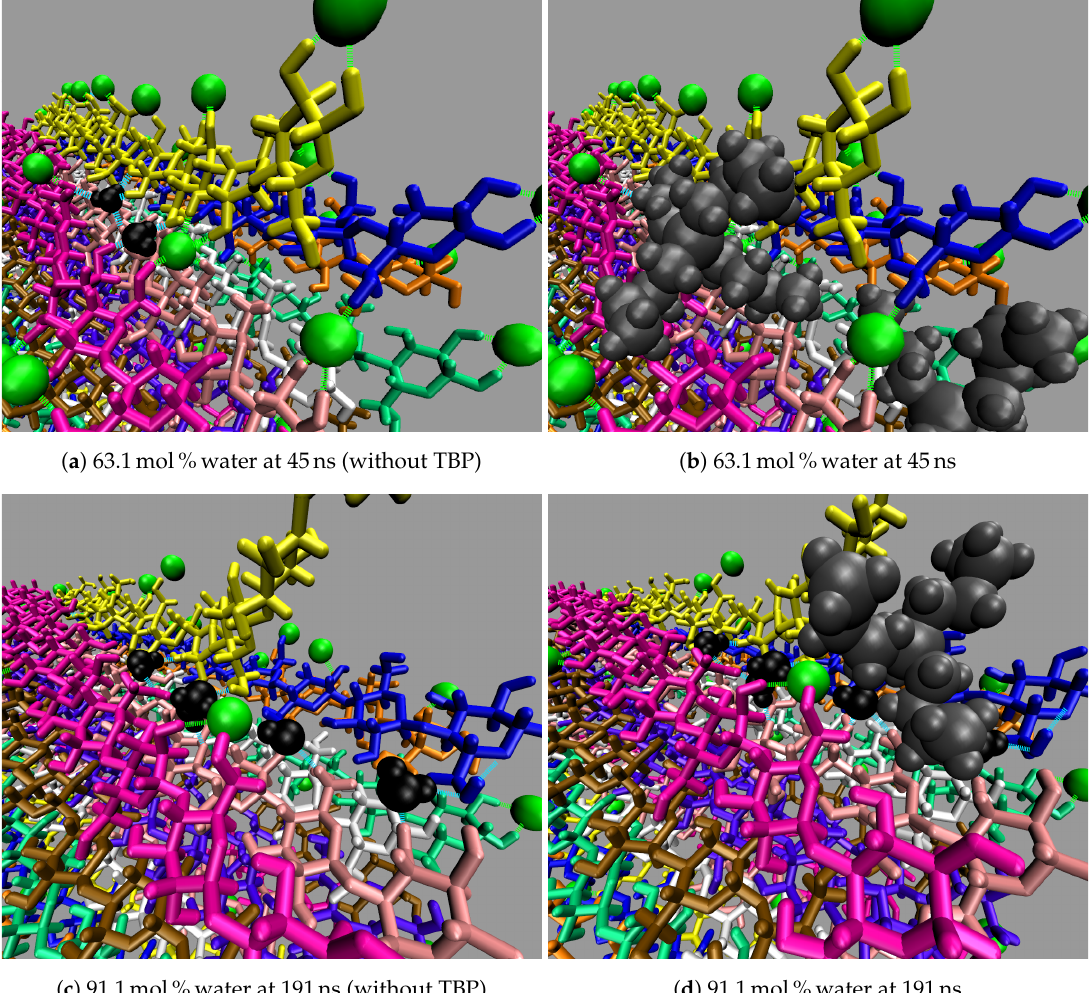
Figure 16. The cellulose dissolution process for: ( a ) the 63.1mol%water concentration at 45ns (without TBP); ( b ) the 63.1mol%water concentration at 45ns; ( c ) the 91.1mol%water concentration at 191ns (without TBP); and ( d ) the 91.1mol%water concentration at 191ns. The green dashed lines are the Cl–cellulose hydrogen bonds, while the light blue dashed lines are the water–cellulose hydrogen